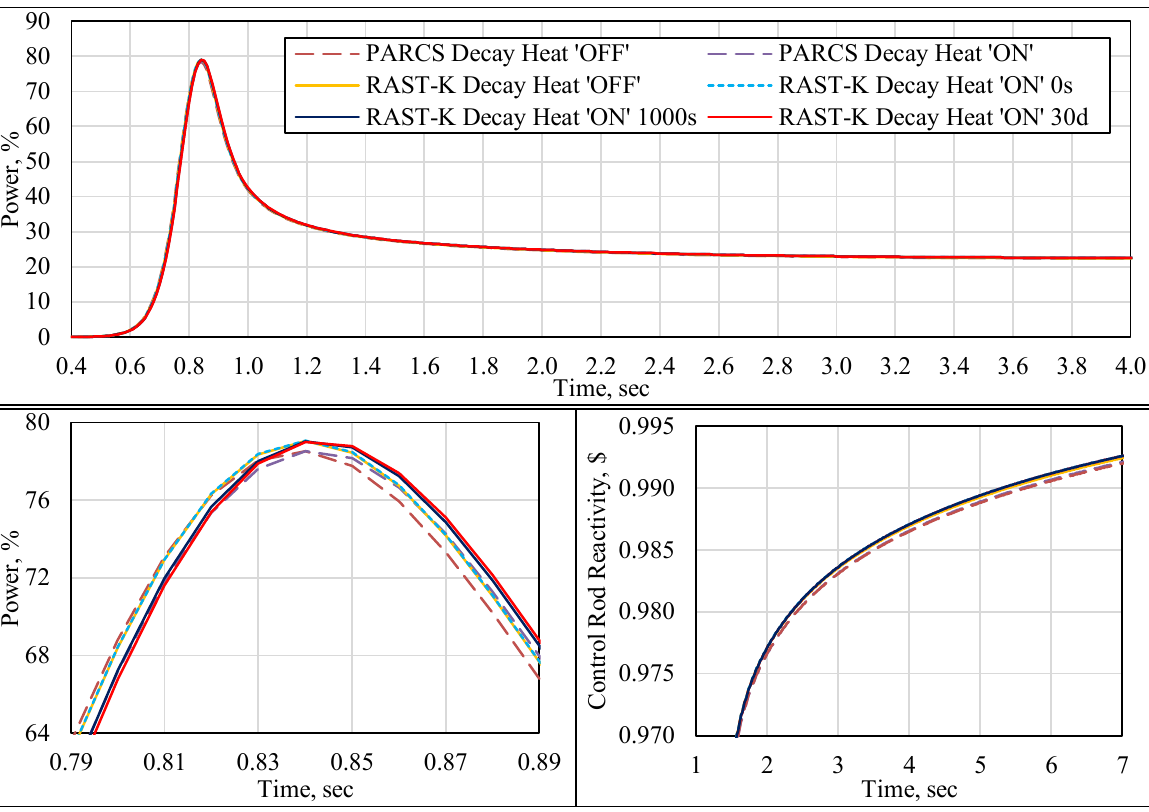
Figure 2. Power change for the NEACRP HZP REA scenario (bottom left - hand side – impact of DH on the value of power, bottom right - hand side - impact of DH on the CR